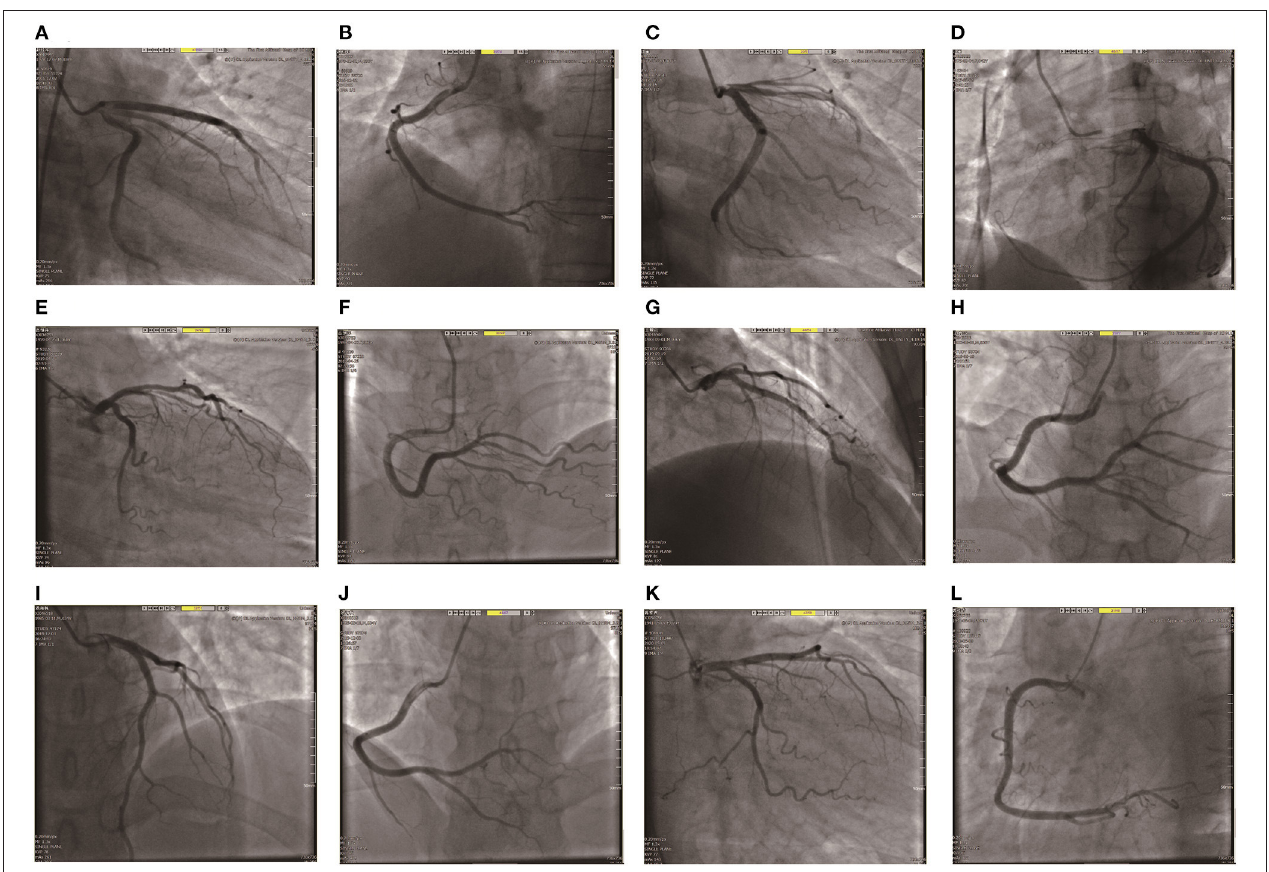
FIGURE 3 | Coronary angiographic images of 6 patients. (A,B) The Coronary angiography of patient 1, which suggested slow coronary blood flow, LAD TIMI1-2; LCX TIMI1-2; Middle branch TIMI 2; RCA TIMI. (C,D) The Coronary angiography of patient 2, LAD30% localized TIMI2, the rest TIMI3; (E,F) The Coronary angiography of patient 4, LADD1 proximal 60%, LAD middle 40% TIMI3. (G,H) The Coronary angiography of patient 6, Coronary angiography showed no significant stenosis. (I,J) The Coronary angiography of patient 7, Coronary angiography showed no significant stenosis. (K,L) The Coronary angiography of patient 9, The proximal LAD was limited to 40% stenosis, the middle RCA was limited to 30%, and the blood flow was slow throughout the LCX.